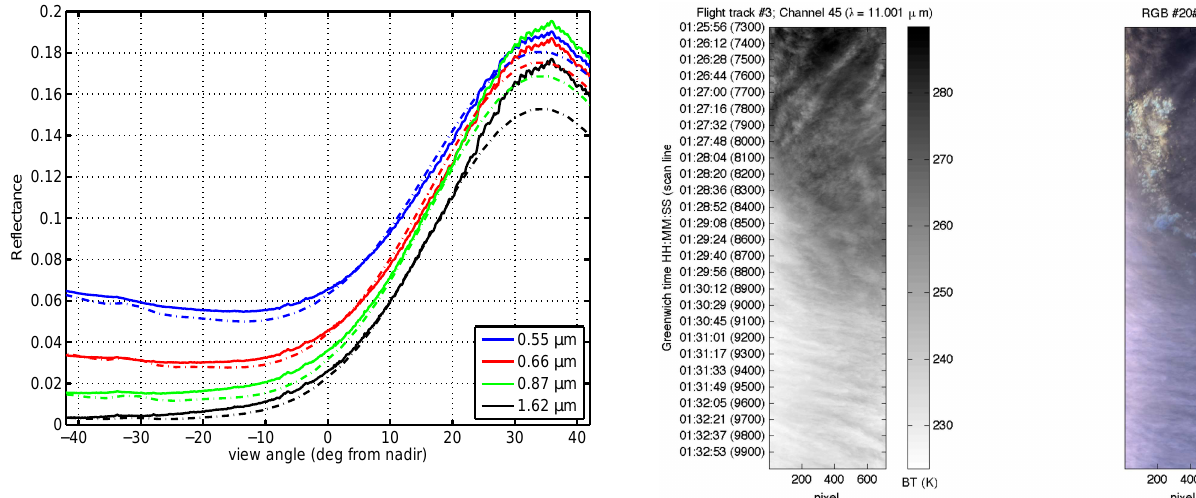
Fig. 7. Reflectance comparison between LBLMS (dashed lines) and MAS (continuous lines) along a MAS scan. Wind speed is 6.5m/s, aerosol OD at 532nm 0.07 and pigment concentration 0.07mg/m 3 .